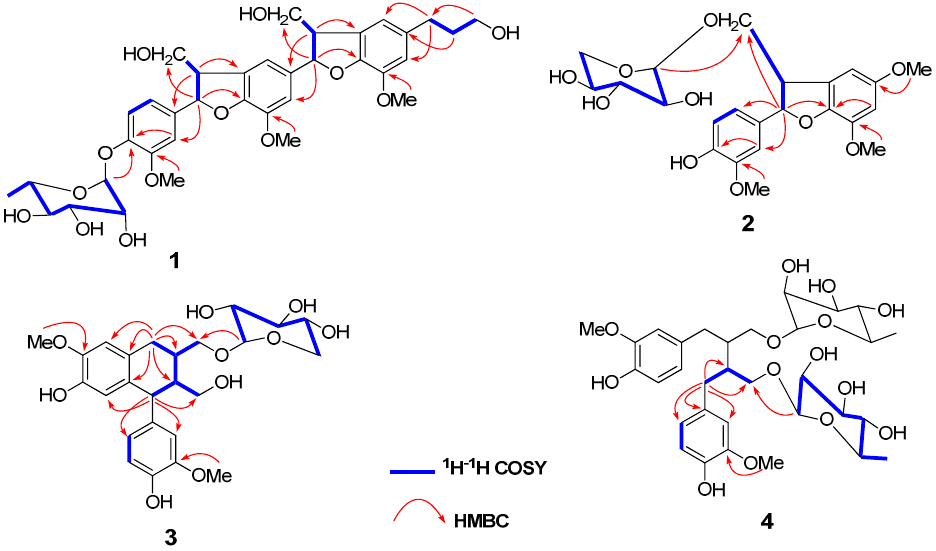
Figure 1. Chemical structures of 1–11.